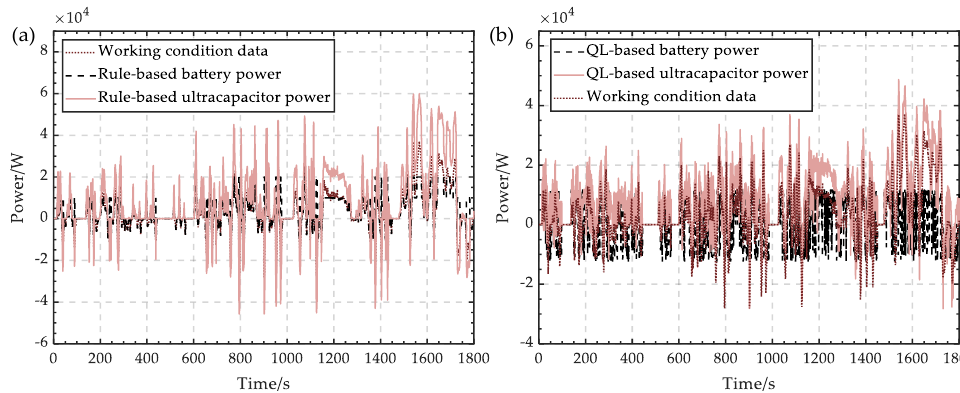
Figure 6. Results of power allocation. ( a ) Rule-based strategy. ( b ) QL-based